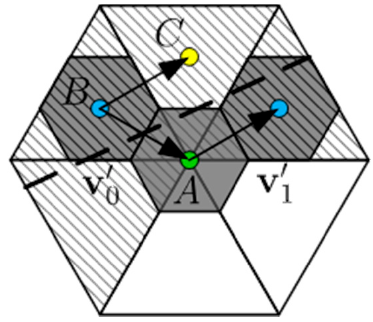
Figure 6. The triangles to which the blue dots correspond have the same direction.